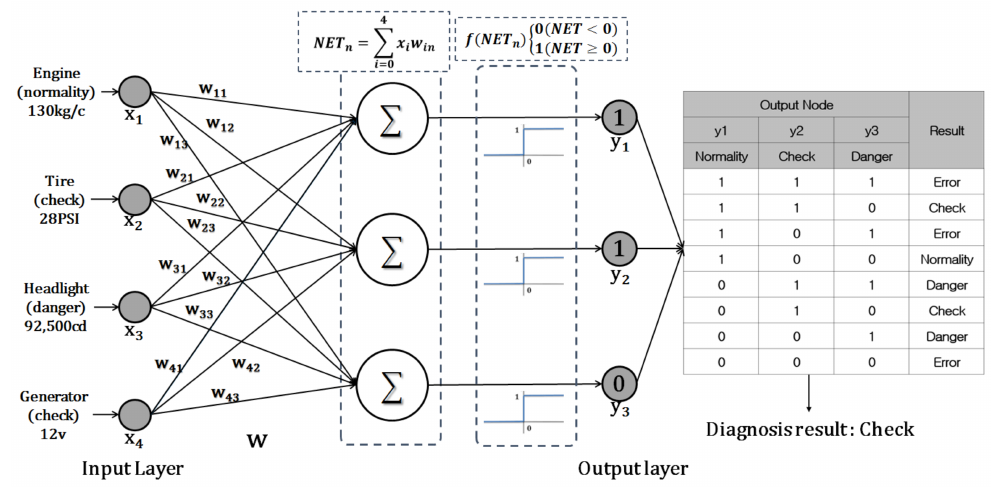
Figure 8. The example of the Total Diagnosis Sub-module (TDS) perceptron operation.